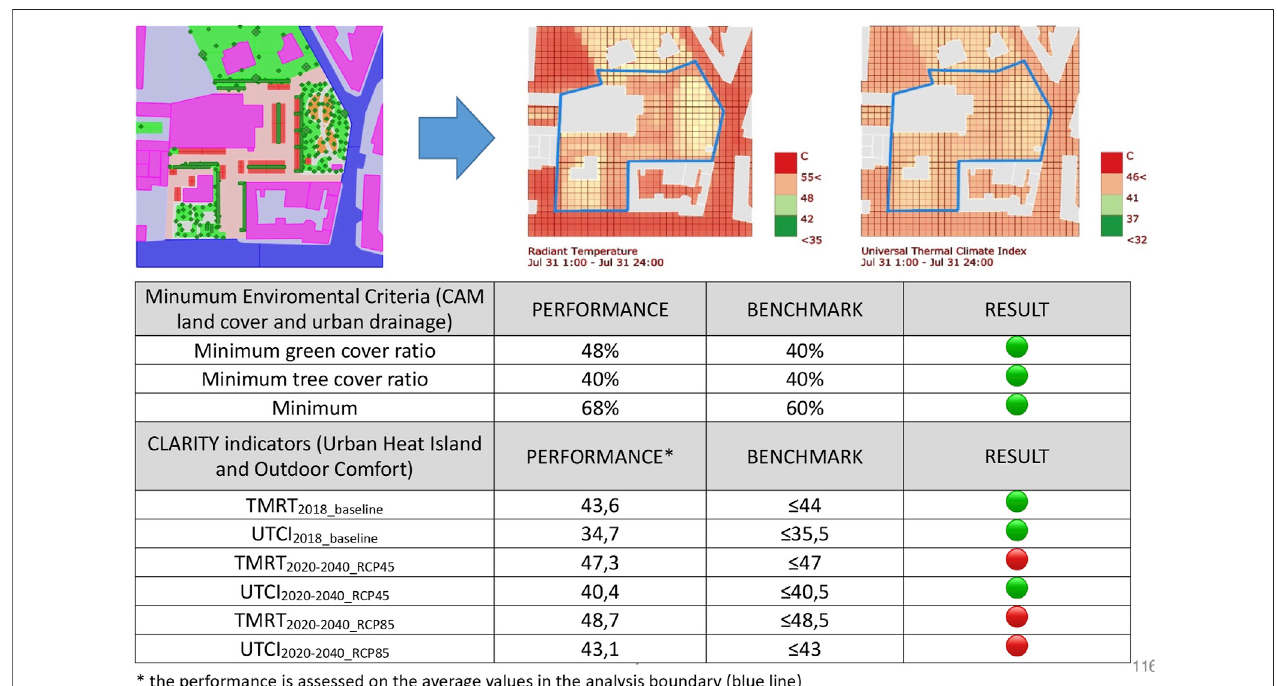
FIGURE 12 | Analysis of an adaptation project for a sample district classi fi ed as an “ urban regeneration area ” in the PUC.